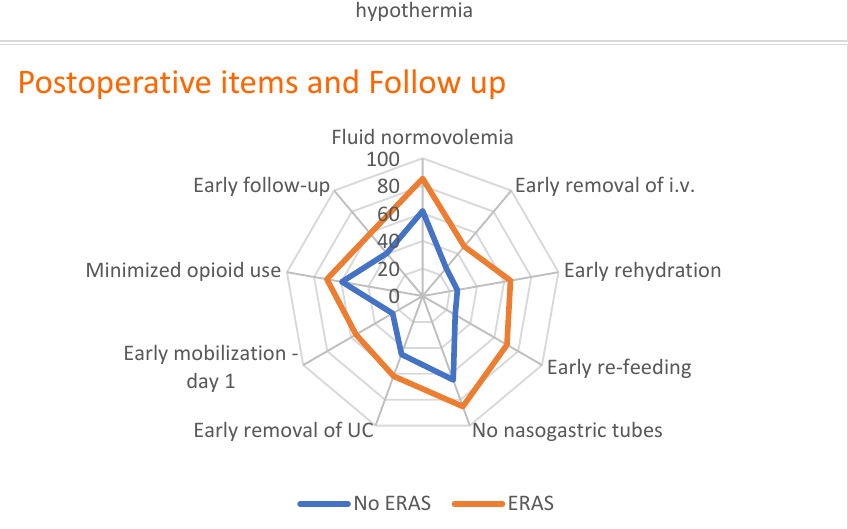
Figure 1. Level of compliance to single ERAS items by type of center (non-ERAS and ERAS). LPT = laparotomic; i.v. = intra venous; UC = urine catheter. Among intraoperative items, epidural anesthesia in open surgery had a low level of compliance in both groups (44% in non-ERAS and 36% in ERAS), as well as the